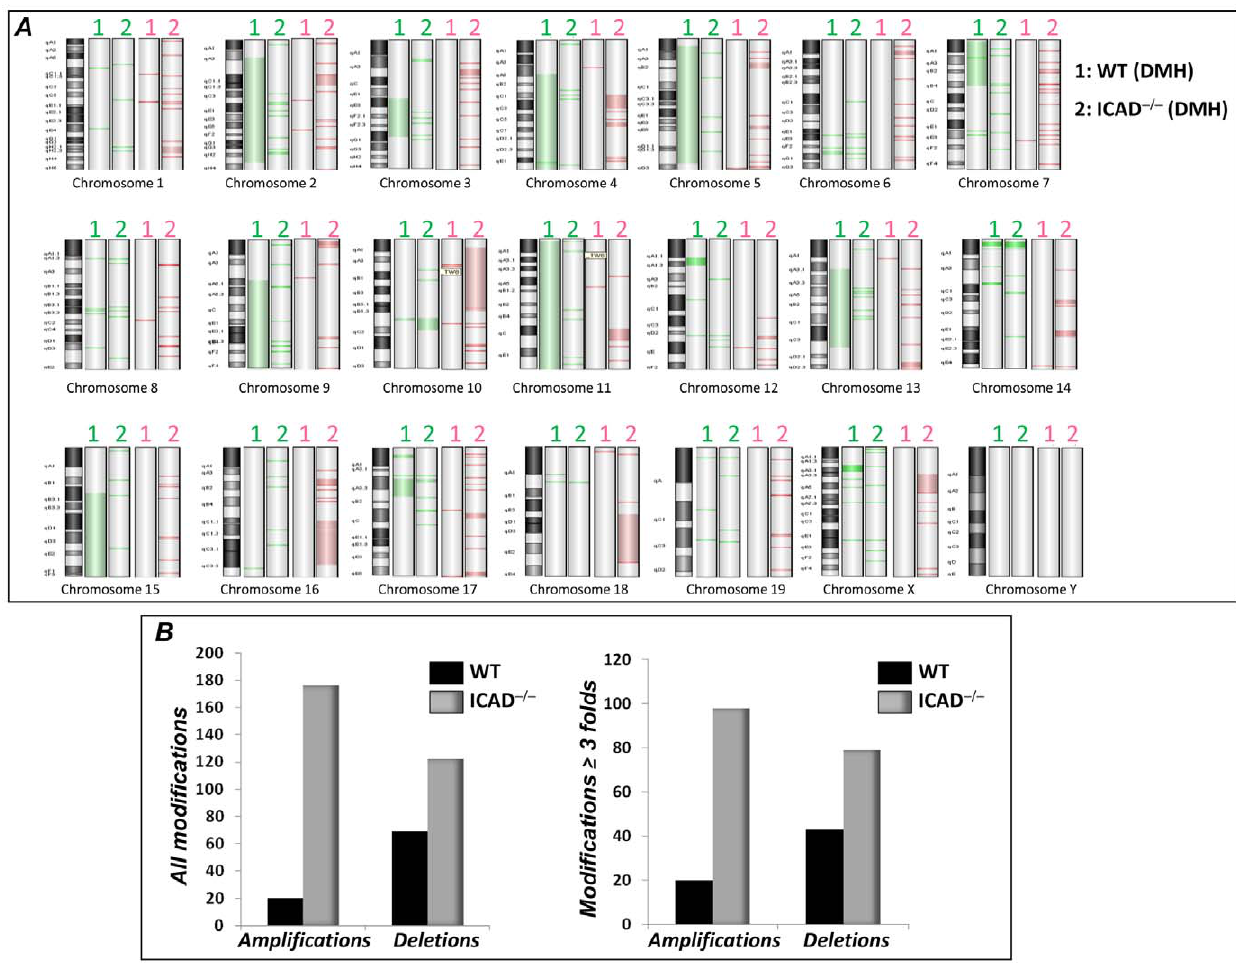
Figure 5. ICAD-deficiency is associated with severe genomic instability in colon of DMH-treated mice. Chromosomal DNA isolated from the different experimental groups was assessed for general chromosomal aberrations using an oligo microarray-based CGH with a chip containing 105,000 mouse genomic probes. DNA from colon tissue of age-matched naı¨ve WT or ICAD 2 / 2 mice were used as reference controls. Test and reference DNA were labeled by random priming with Cy5-dUTP and Cy3-dUTP, respectively, using the Agilent Genomic DNA Labeling Kit Plus. The individually labeled test and reference samples were concentrated and then combined. Following probe denaturation and pre-annealing with mouse Cot-1 DNA, hybridization was performed as described in the methods. Data including Copy Number Variations were obtained by Agilent Feature Extraction software 9 and analyzed with Agilent Genomic Workbench software 5.0, using the statistical algorithms z score and ADM-2 according to sensitivity threshold respectively at 2.5 and 6.0 and a moving average window of 0.2 Mb. ( A ) Depiction of amplifications (pink) and deletions (green) throughout the 19 somatic chromosomes and the X and Y chromosomes. ( B ) Quantitative assessment of total aberrations (left panel); the right panel represents data attained when stringency was increased and a cutoff of a 3-fold change was applied; p , 1 6 E 2 11